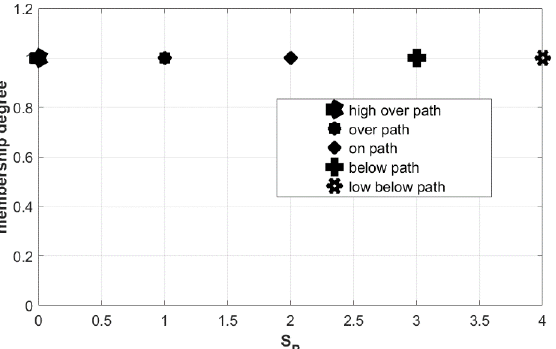
Figure 9. Membership degree of the input variables of the number of red PAPI lights S P associated with fuzzy sets: very high over path, over path, on path, below path, and low below path. The signal S P is discrete, with values of 0, 1, 2, 3, and 4 only. Therefore, the